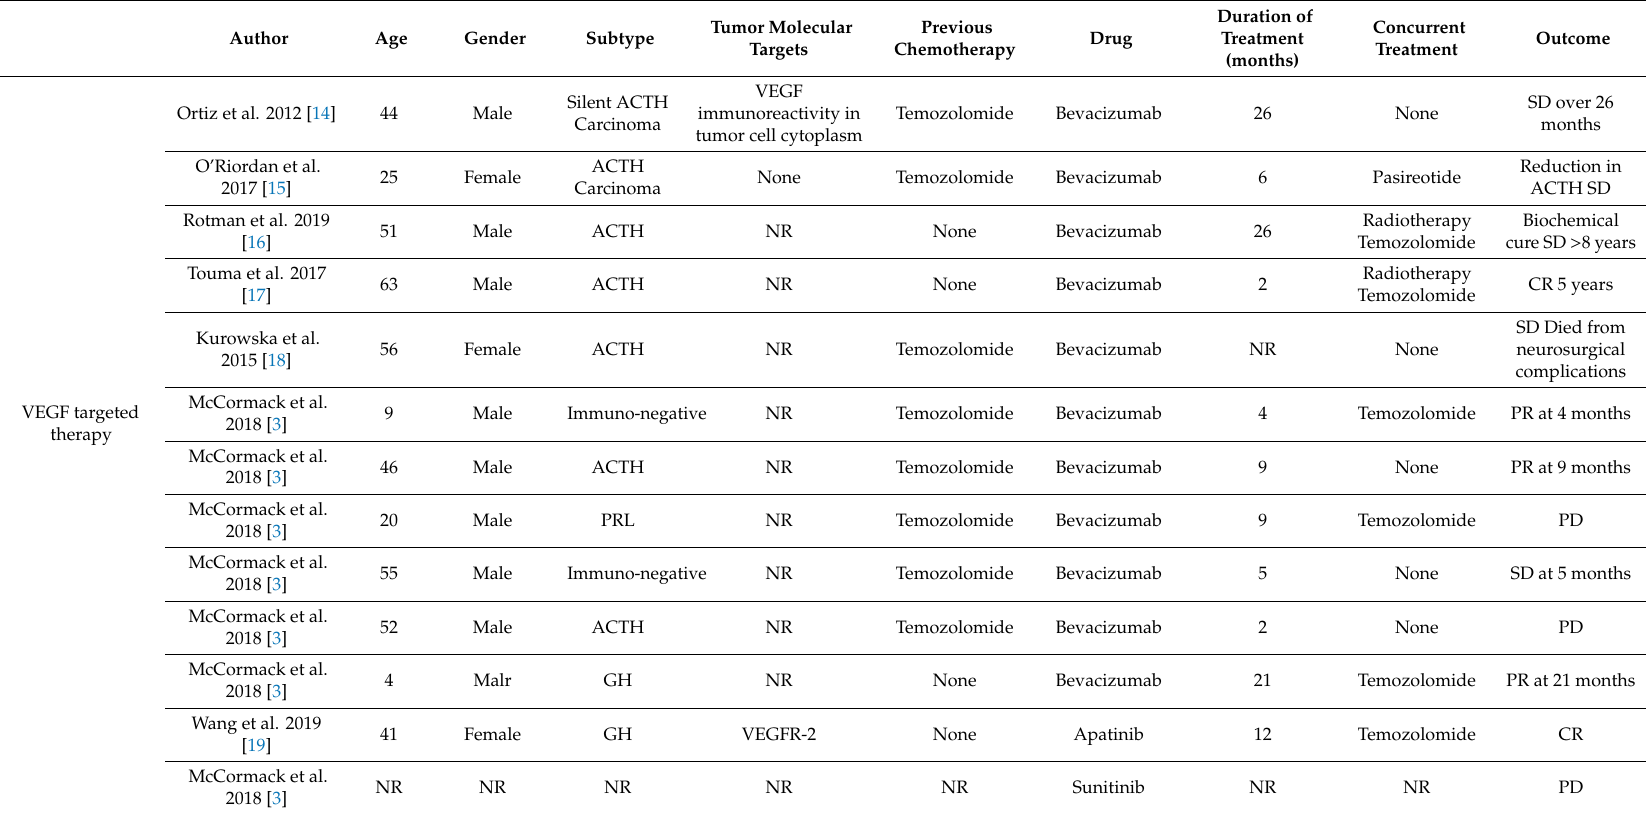
Table 1. Published cases of targeted therapies for aggressive pituitary